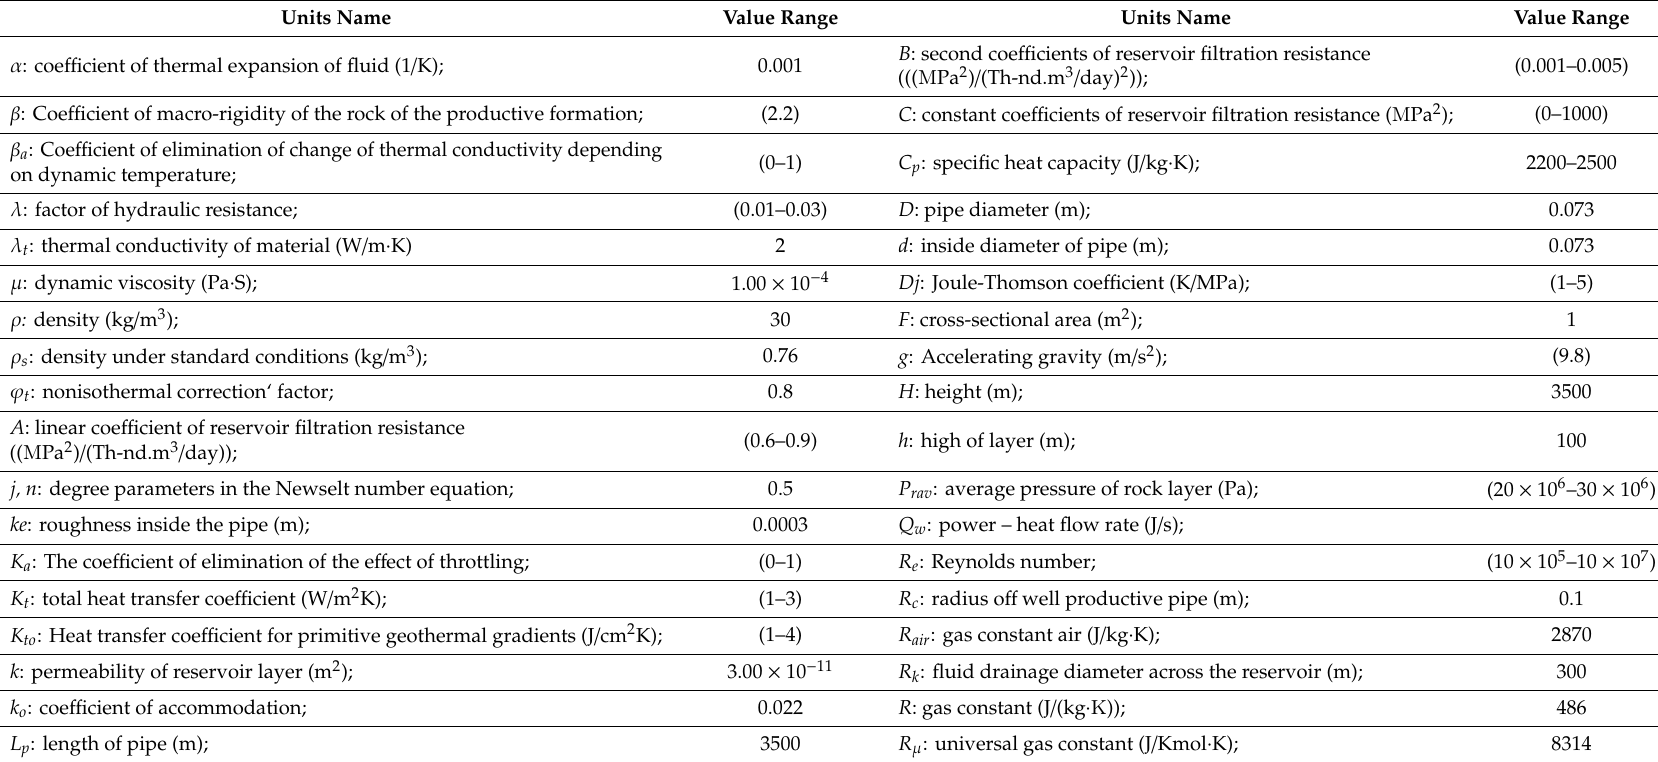
Table 1. The nomenclature of parameters and the range of application of their values in the